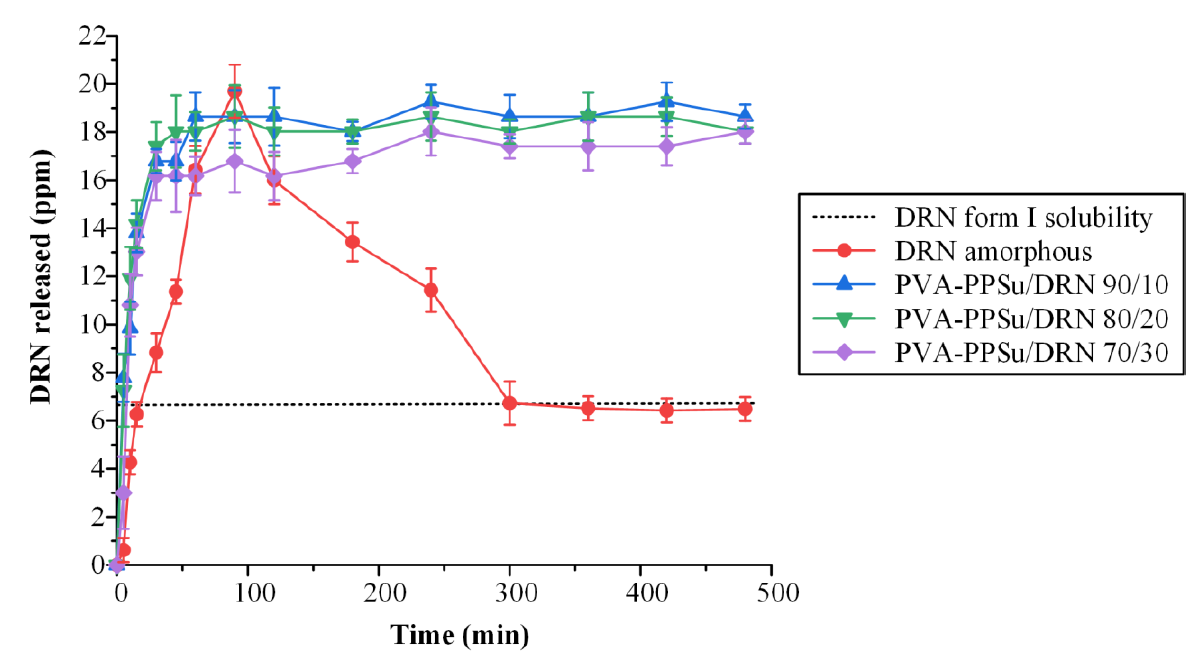
Figure 12. In vitro dissolution profiles under nonsink conditions of the neat amorphous DRN and all prepared ASDs (the dashed line represents the saturation solubility of DRN form I crystals).